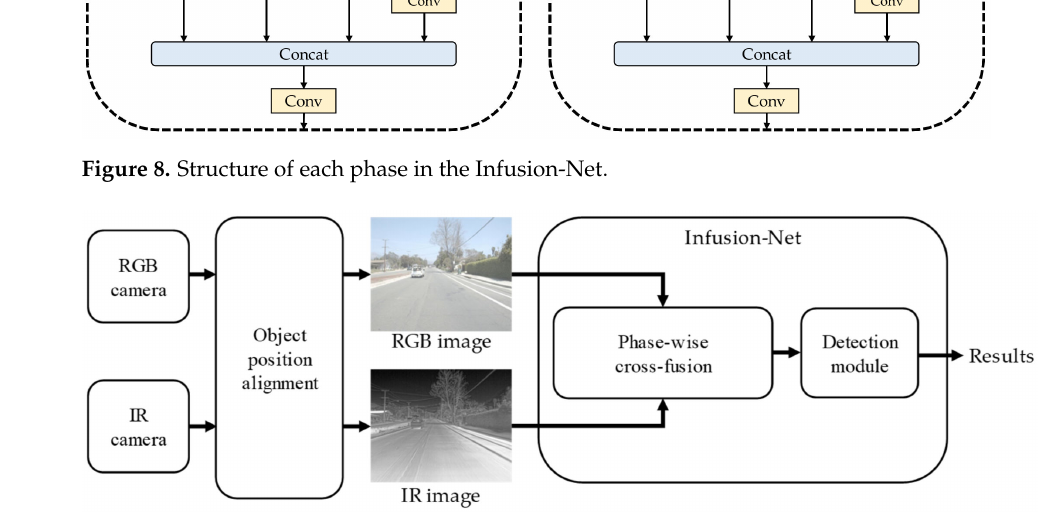
Figure 9. Step-by-step block diagram of an application of